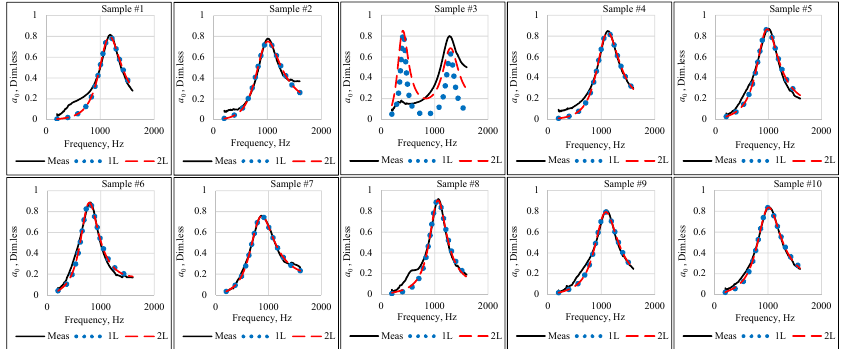
Figure 9. a 0 plots (optimization in 600–1600 Hz, estimated resistivity)